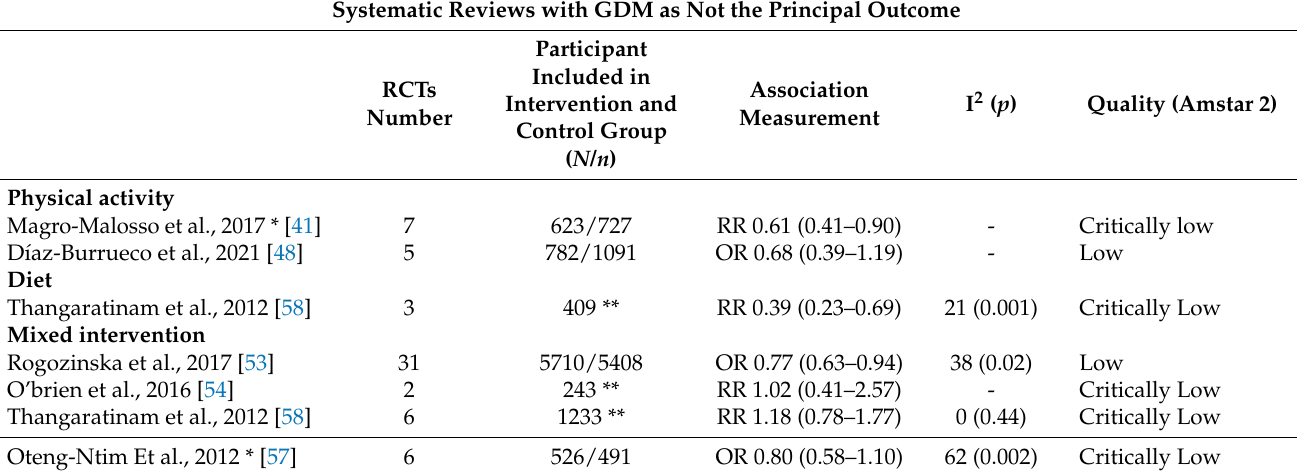
Table 5. Systematic reviews finding including GDM as a secondary